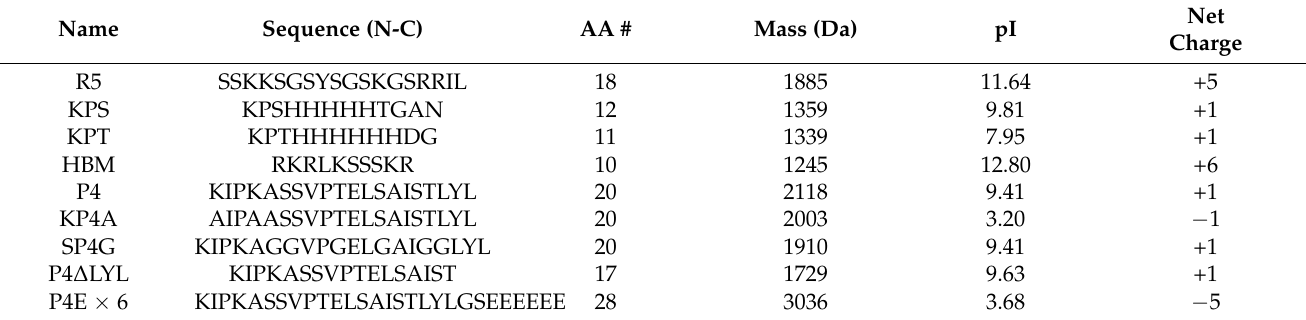
Table 1. Peptide sequences and their